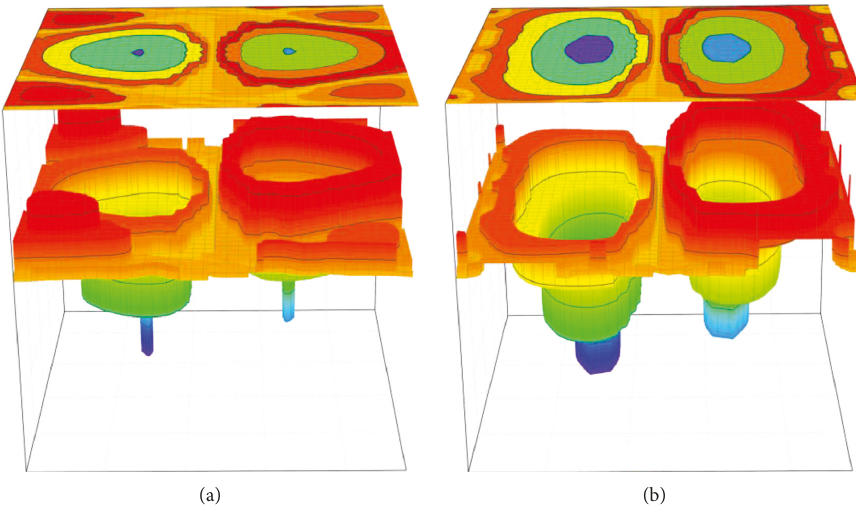
Figure 12: 3D cyclic stress invariant of soil at the base of soil foundation, using matrix for numerical simulation. (a) Configuration-1. (b)